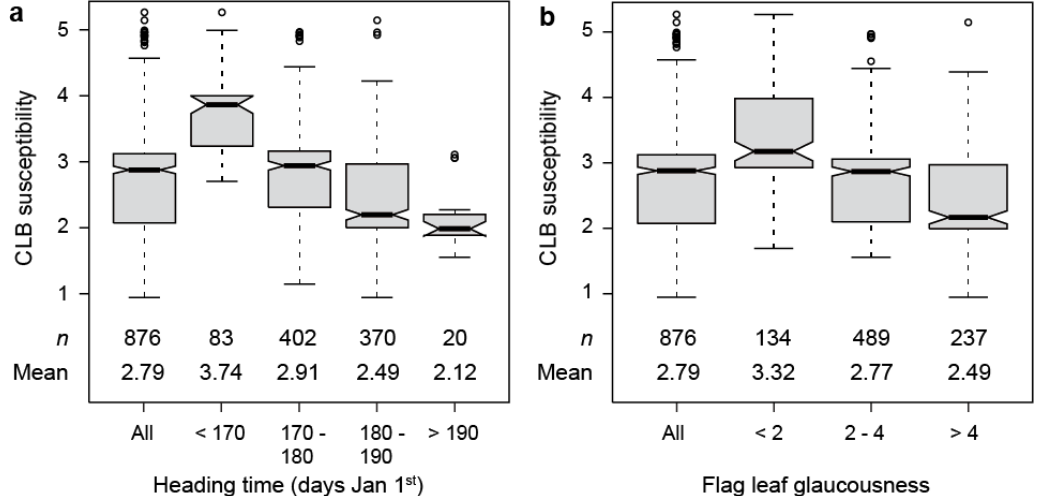
Figure 2. Boxplots showing the association between cereal leaf beetle (CLB) susceptibility and ( a ) heading time and ( b ) flag leaf glaucousness (scored on a 1–6 scale, with 1 being no glaucousness on the abaxial and adaxial sides of the flag leaves, and 6 being fully glaucous flag